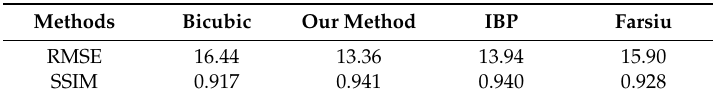
Table 1. The RMSE and SSIM between the original and reconstructed images obtained from bicubic interpolation, IBP, Farsiu’s method and the proposed